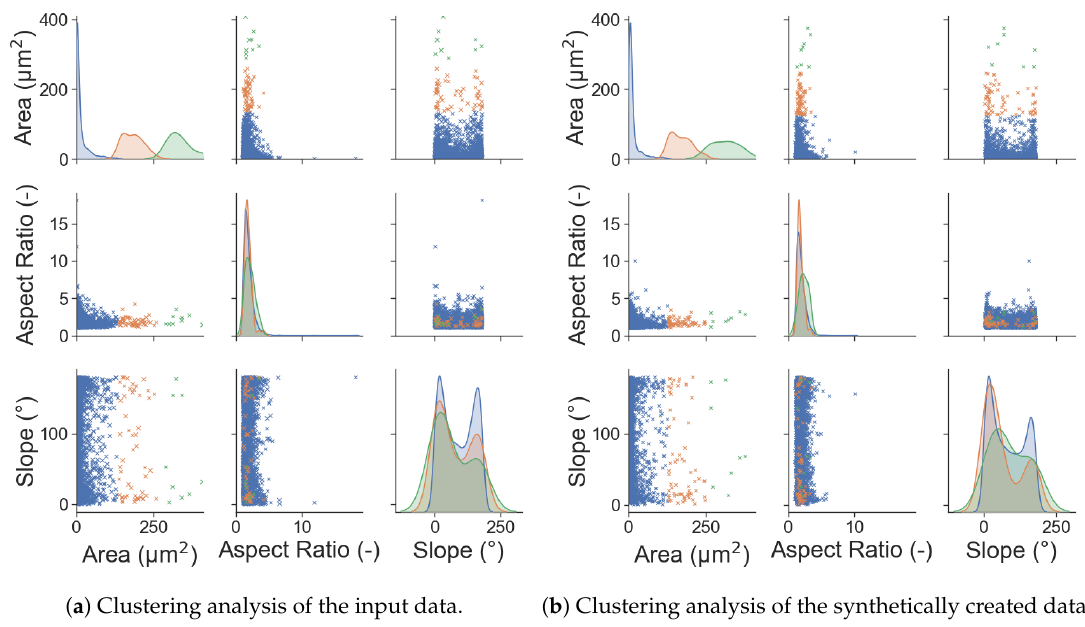
Figure 10. Comparison between the clustering analysis of the input data and the generated output data. The area was divided into three equally sized sections for this